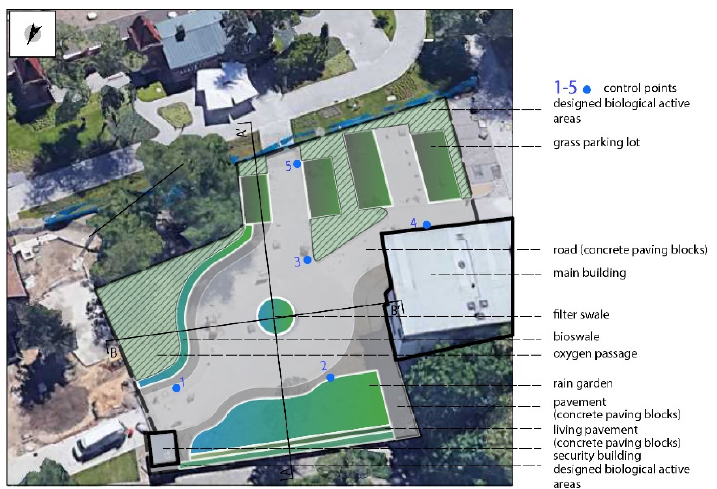
Figure 2. The diagram of the introduced design interventions and location of control points (1. control point above bioswales area, close to group of trees; 2. control point close to rain garden; 3. control point above grass car parks with carpet planting; 4. control point close to main building; 5. control point above grass car parks with sedum carpet, close to group of trees). Solid lines indicate the position of the cross sections AA’ and BB’.